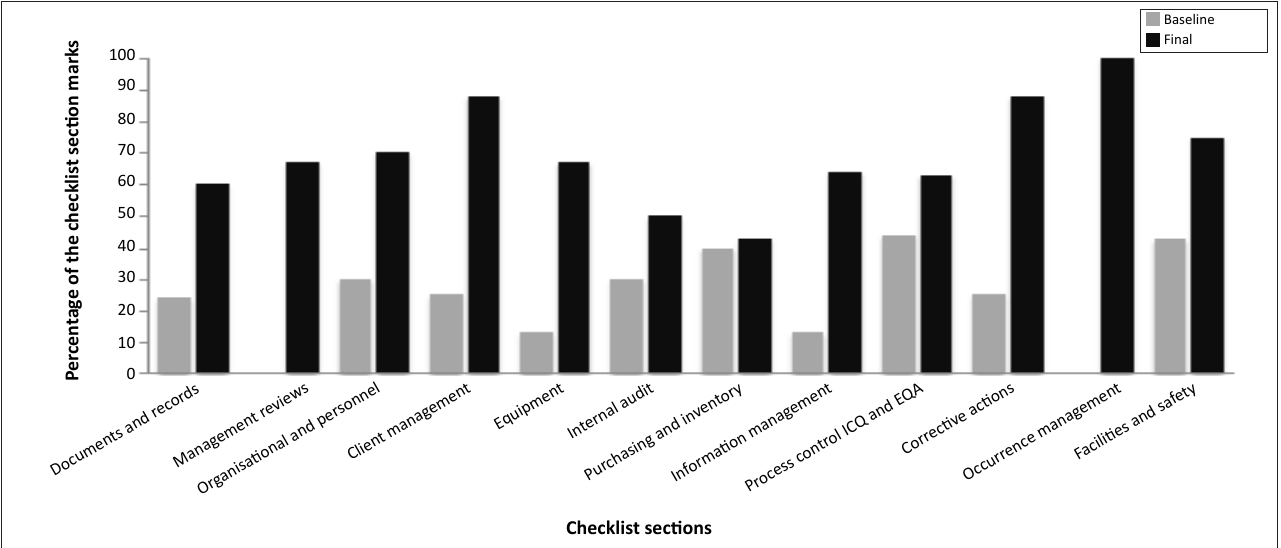
FIGURE 4: Average performance (based on the WHO-AFRO SLIPTA checklist) of the three district laboratories over the 10 weeks mentorship measured at the four time points during the study: (1) initial baseline, (2) exit after first six weeks mentorship, (3) start of second mentorship period and (4) at the end of the 10 weeks of mentorship. Average marks of the three laboratories are expressed as a percentage of the weighted total for each of the 12 sections of the checklist. TABLE 6: Assessment scores at specific time points during the mentorship periods at Queen Elizabeth II Central Laboratory. Laboratory section